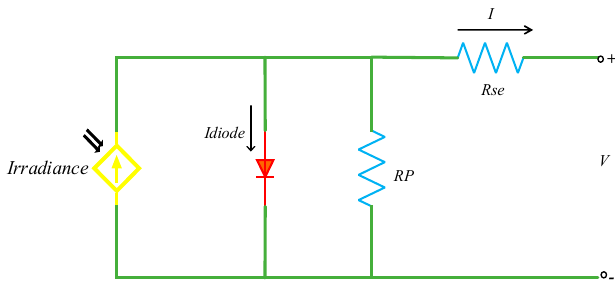
Figure 1. Electrical equivalent model of SDM.